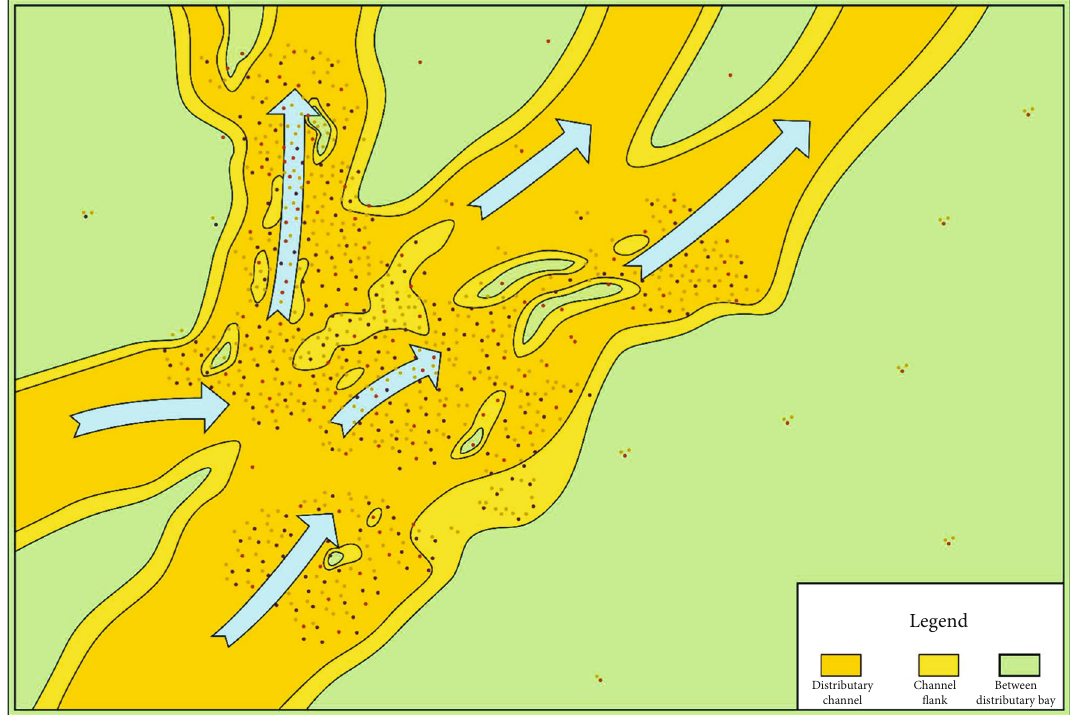
Figure 8: Sedimentary microfacies characteristics of the